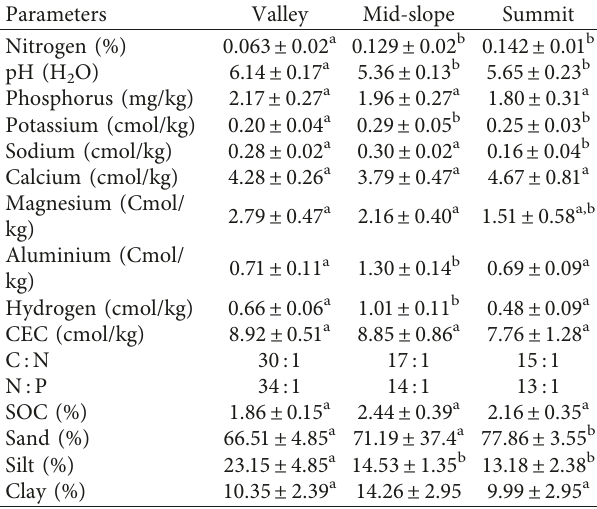
Table 4: Variations in soil nutrients under a 7-year-old teak plantation at different elevations. The values are means and their associated standard error.